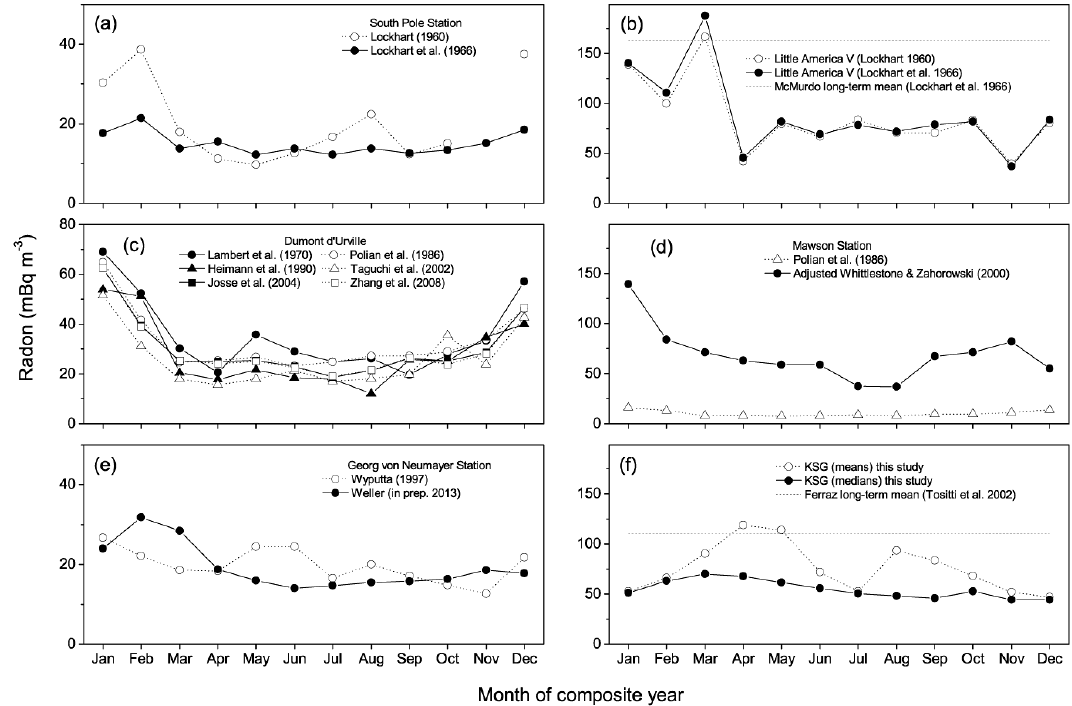
Figure 9. Seasonal cycles of radon concentration in Antarctica observed using the indirect progeny method ( a , b , c and e ) and the direct two-filter method ( d , f ). Values are monthly means, unless otherwise stated. See Table 1 for measurement